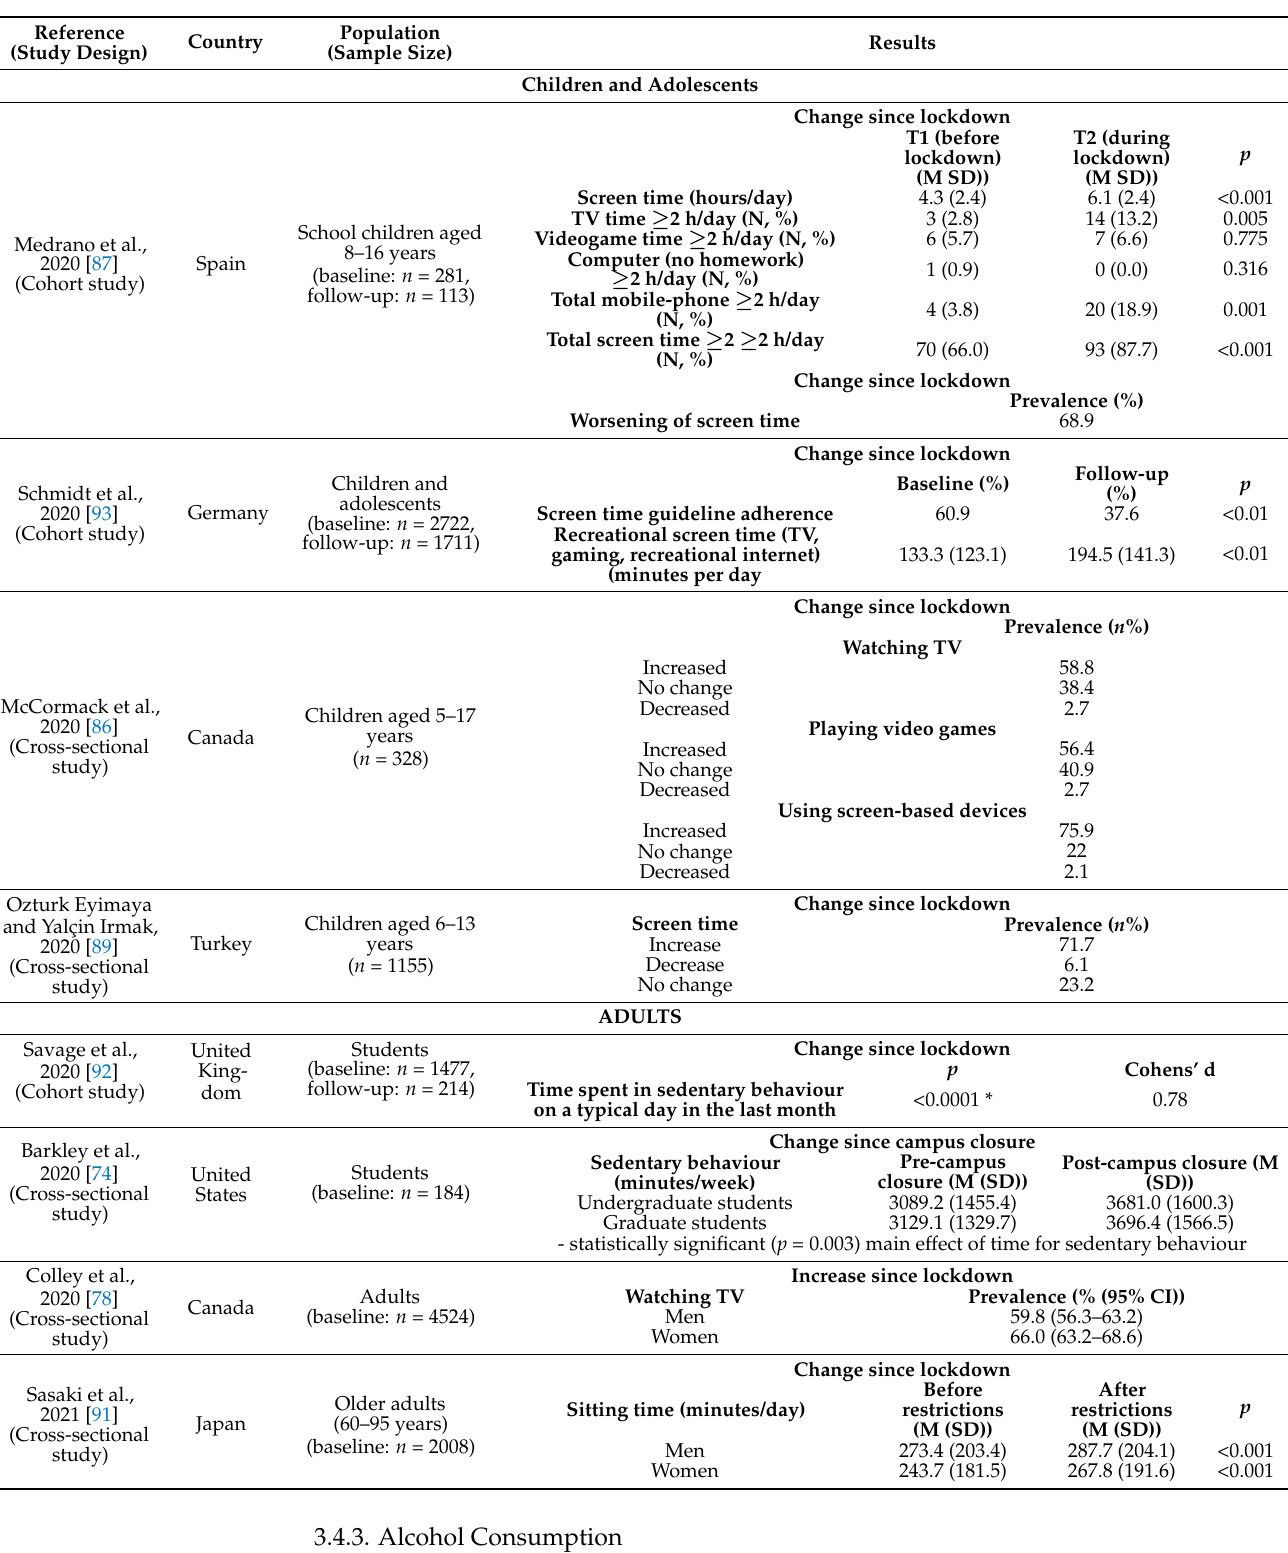
Table 5. Results on sedentary behaviour. * adjusted for year, age group, gender, ethnicity, period and period × age group